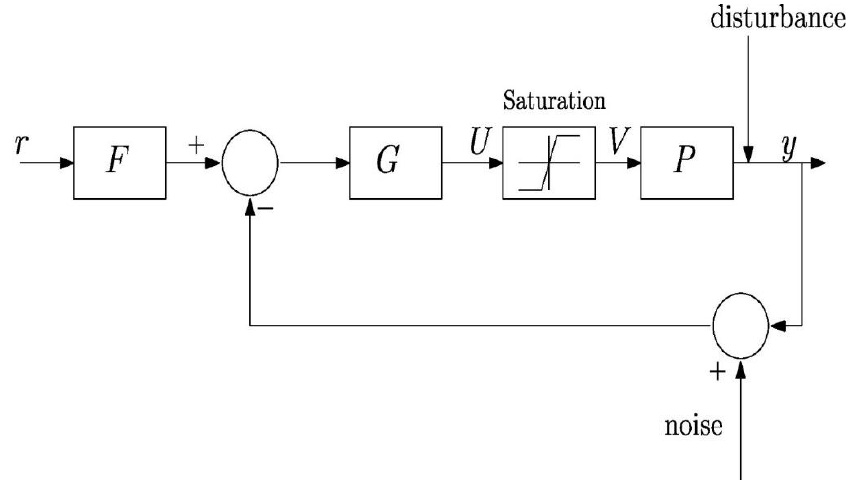
Figure 1. A two degree of freedom (2-DOF) structure with actuator saturation.